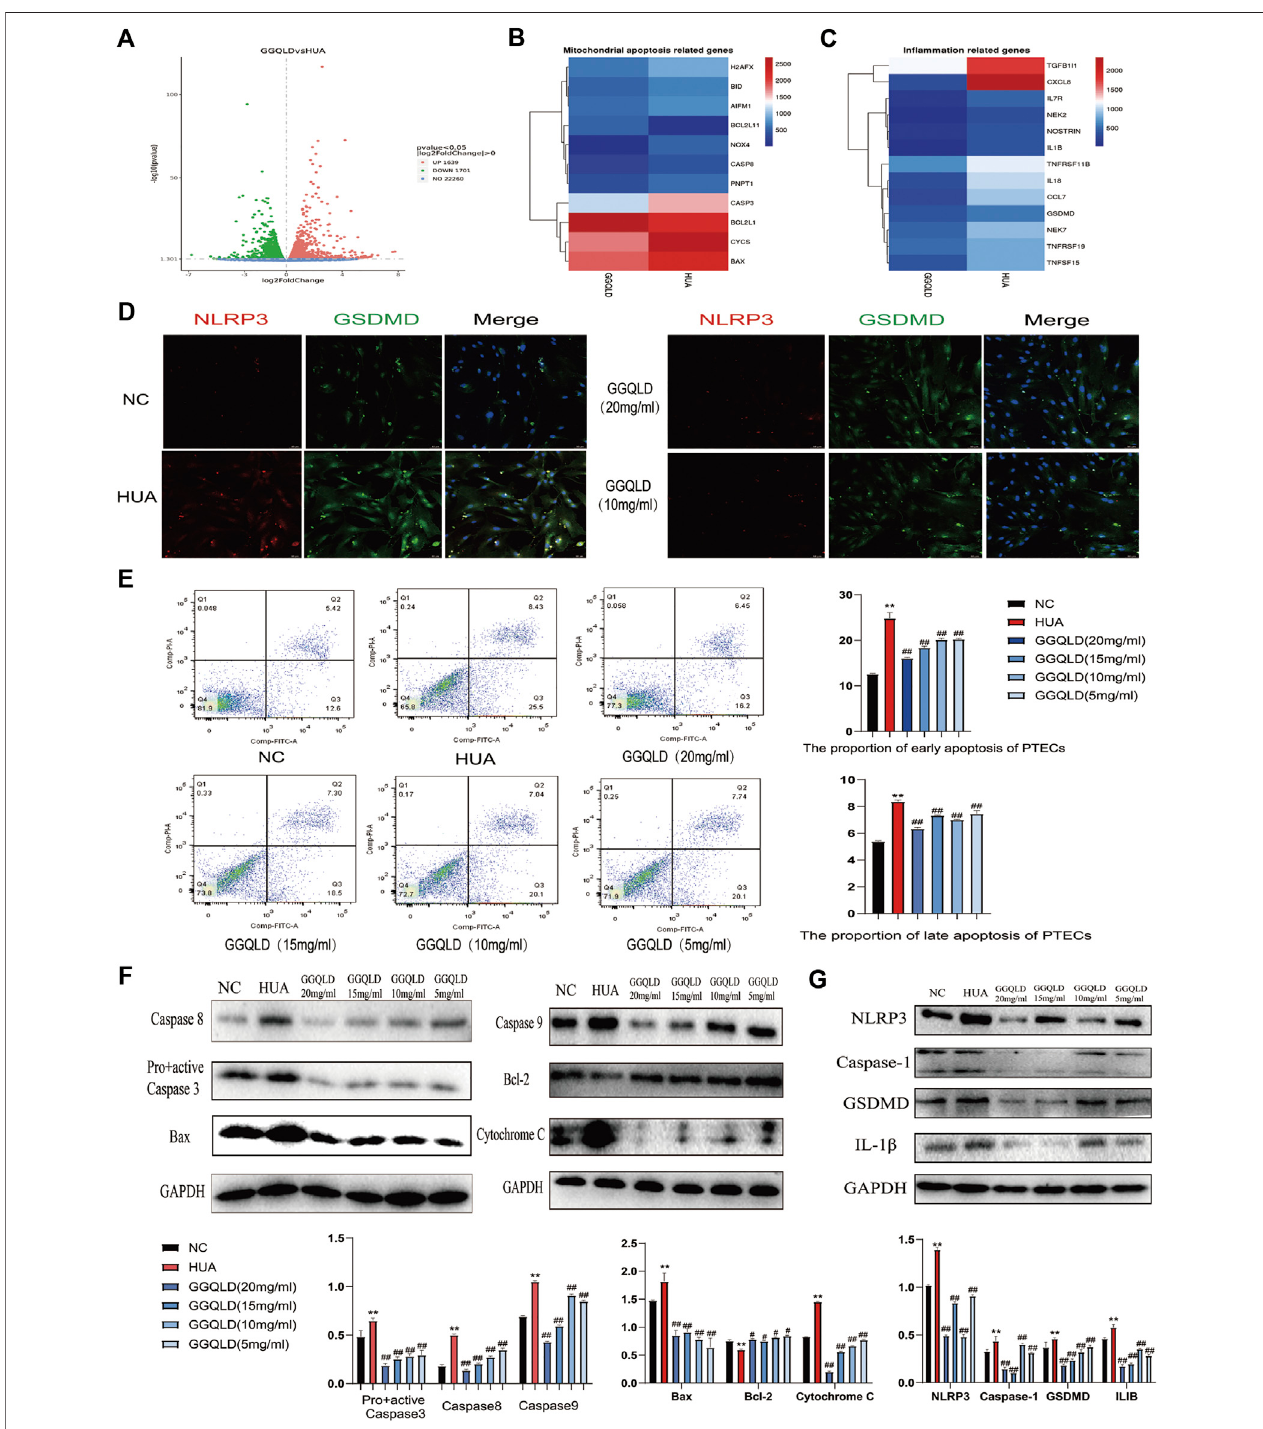
FIGURE6| GGQLDinhibitsmitochondrialapoptosisandin fl ammationinPTECs. (A) Geneexpression pro fi lewascomparedbetweencellsinresponsetoGGQLD treatment, and heat maps were generated based on expression of the signi fi cantly changed genes related to in fl ammatory response and the mitochondrial apoptosis process (B,C) . (D) GGQLD alleviating in fl ammasome-induced pyroptosis through inhibiting the NLRP3/GSDMD signal in UA-stimulated PTECs. (E) GGQLD alleviated earlyandlateapoptosis. (F,G) GGQLDalsoreducedBcl-2,Bax,cytochromec,pro+activecaspase-3,cleavedcaspase-3,caspase-9,andcaspase-8expression in UA-stimulated PTECs. The levels of key proteins of the NLRP3 signaling cascade in PTECs by GGQLD treatment. For (D – G) , n (cid:2) 3 independent experiments per group. * p < 0.05 vs. NC, ** p < 0.01 vs. NC, # p < 0.05 vs. HUA, ## p < 0.01 vs. HUA.